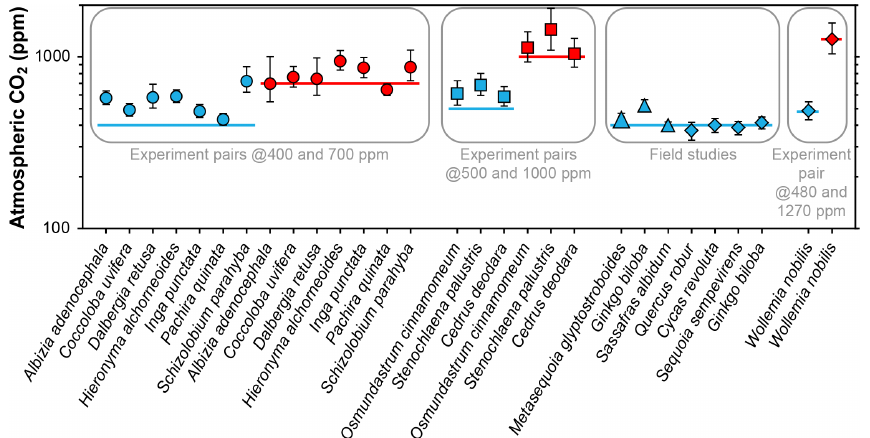
Figure 1. Published CO 2 estimates using the Franks model for extant plants for which the physiological inputs A 0 (assimilation rate at a known CO 2 concentration) and/or g c(op) /g c(max) (ratio of operational to maximum leaf conductance to CO 2 ) were measured directly. Horizontal lines are the correct CO 2 concentrations. Uncertainties in the estimates correspond to the 16th–84th percentile range. Circles are from Londoño et al. (2018), squares from Milligan et al. (2019), large triangle from Maxbauer et al. (2014), small triangles from Kowalczyk et al. (2018), and diamonds from Franks et al.